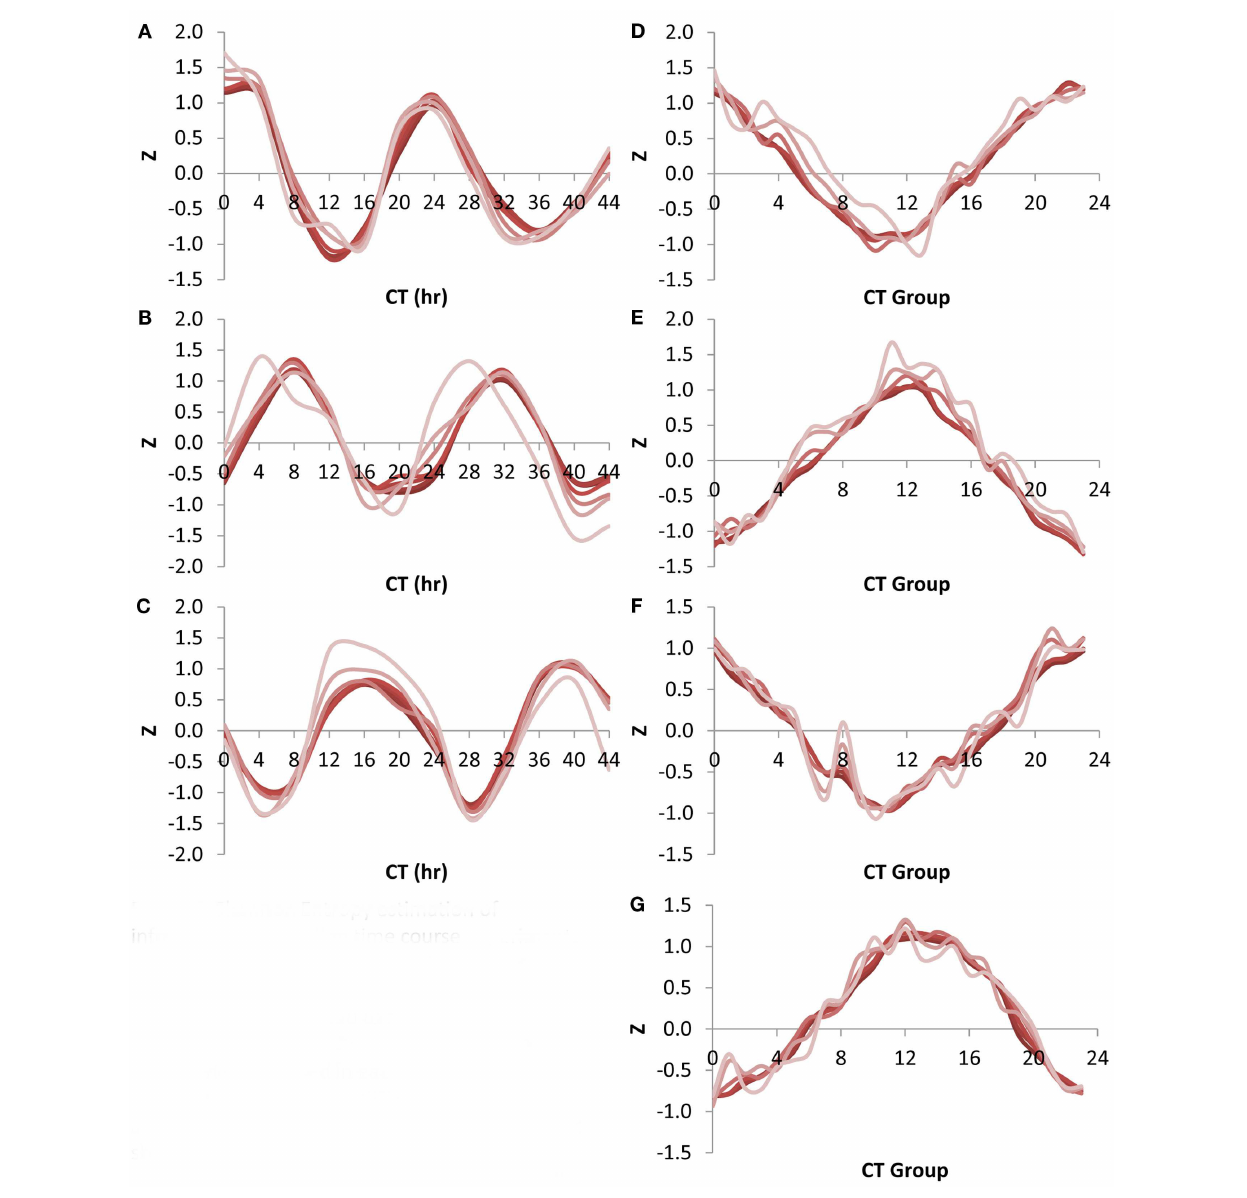
FIGURE 5 | Shannon Entropy estimation of information in circadian time course experiment. A previous microarray analysis of a 44h circadian time course with the Affymetrix ATH1 microarray was obtained to analyze the Shannon Entropy within the analysis.The genes were independently ranked in each time point and the Shannon entropy for the different gene sets analyzed for each time point. In all plots different shades represents the different gene